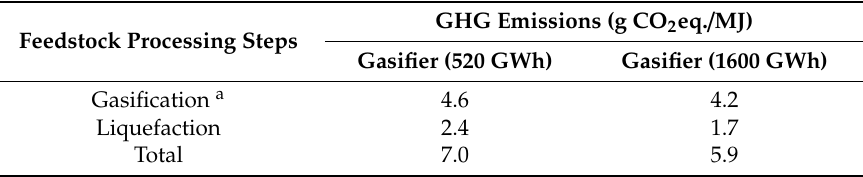
Table 6. Impact of gasifier size on GHG emissions during feedstock processing [26]. Feedstock Processing